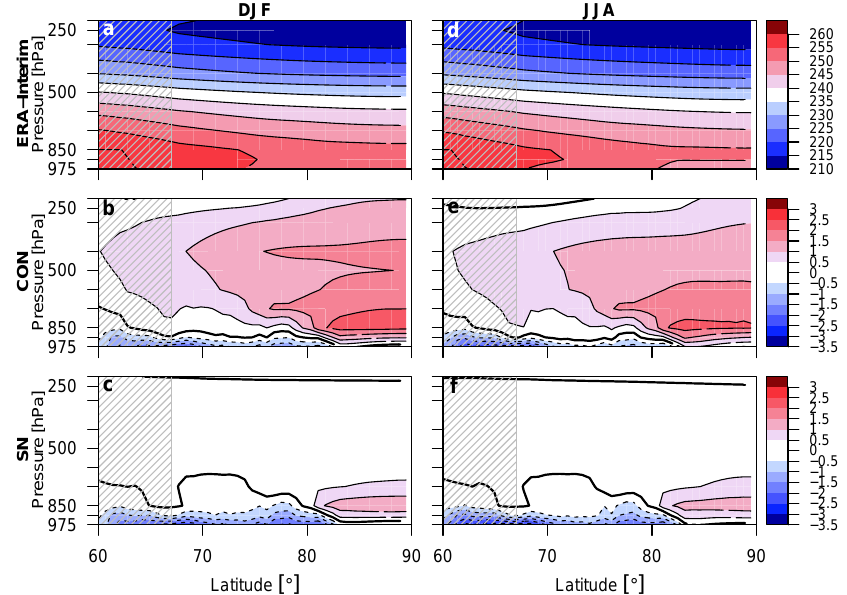
Fig. 4. Zonal mean temperature for ERA-Interim (top), and bias of CON (middle) and SN (bottom), with respect to ERA-Interim, for DJF (left) and JJA (right). The dashed regions indicates latitudes where no complete zonal means were possible (see Fig. 1), in which case also the corresponding ERA-Interim data were disregarded for the bias calculations. Note that only data from the interior domain are used, thus no relaxation to the driving data should be expected in the plots. Units are given in K.